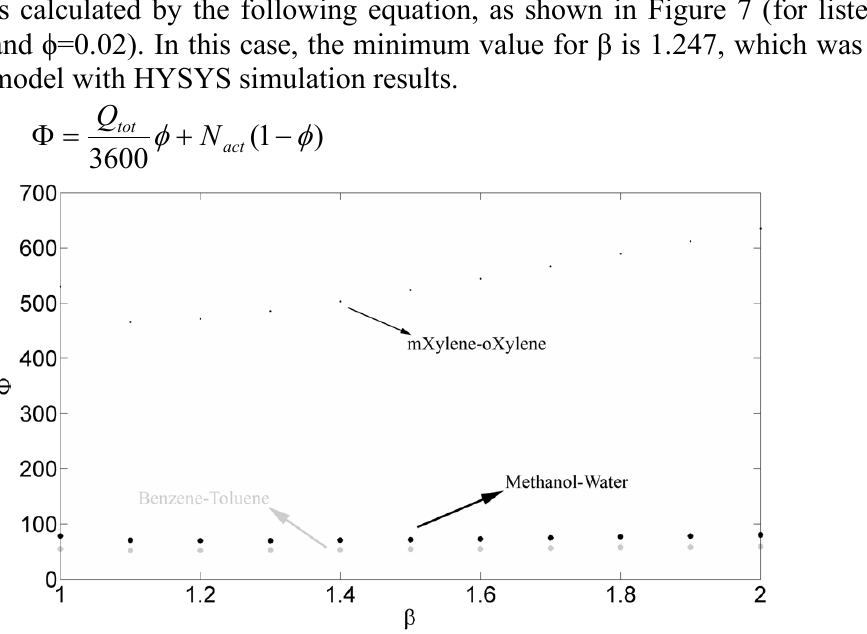
Figure 7. Most economical (optimum) reflux ratio for conditions of Table